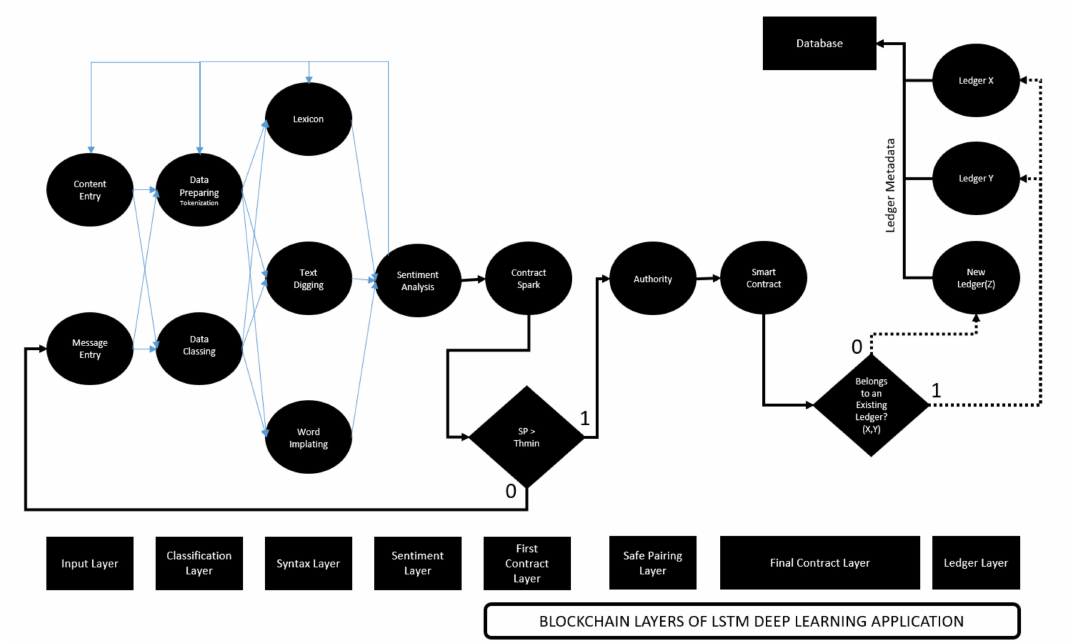
Figure 7. Proposed blockchain–LSTM neural network